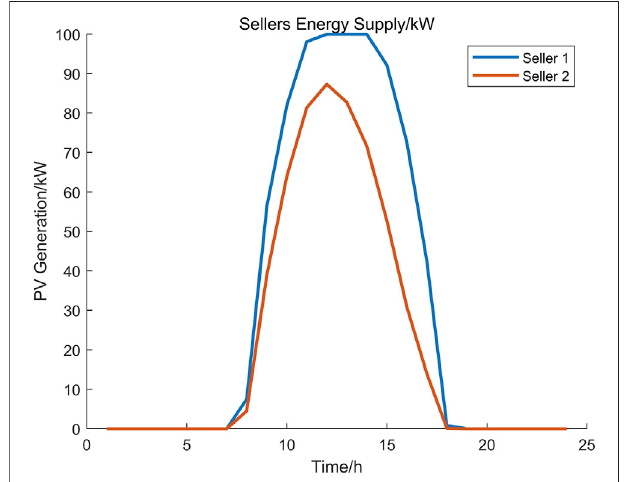
FIGURE 11 | Sellers ’ energy supply in 24 h